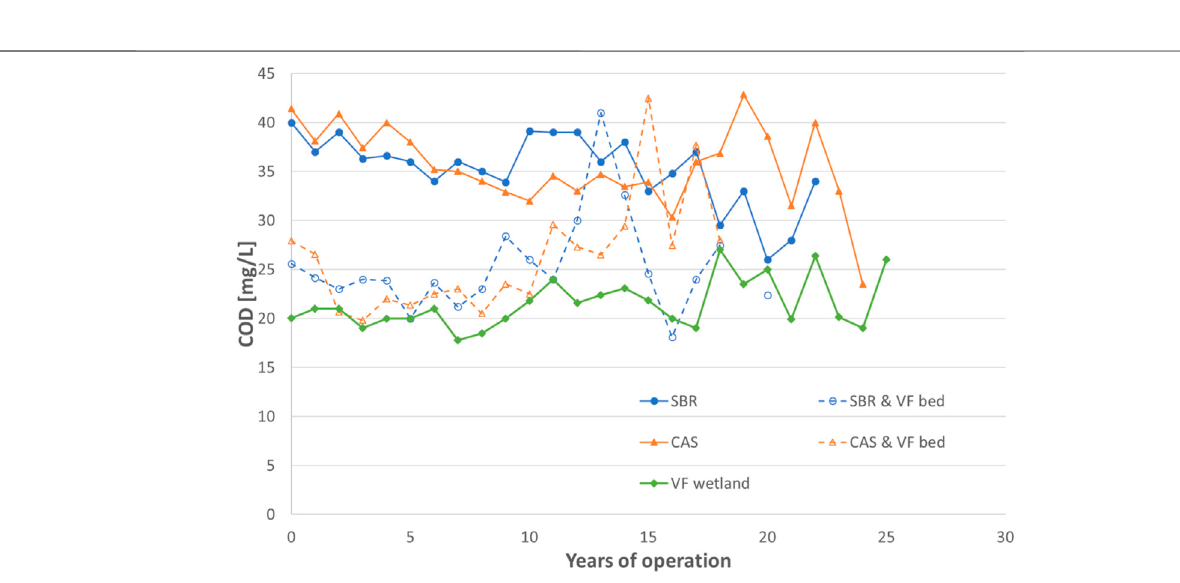
Frontiers in Environmental Science |